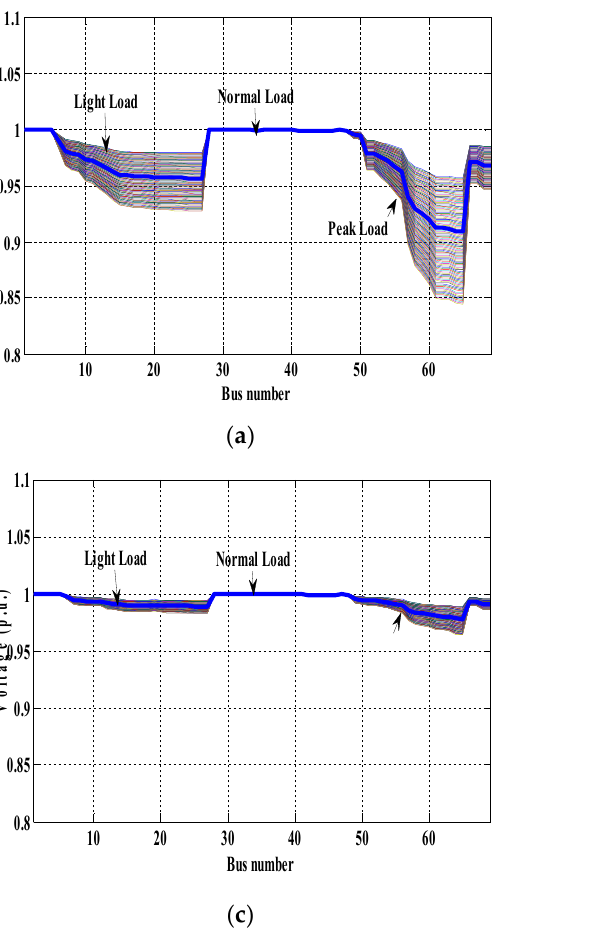
Comparison of power loss reduction (%) for 69-bus test system.